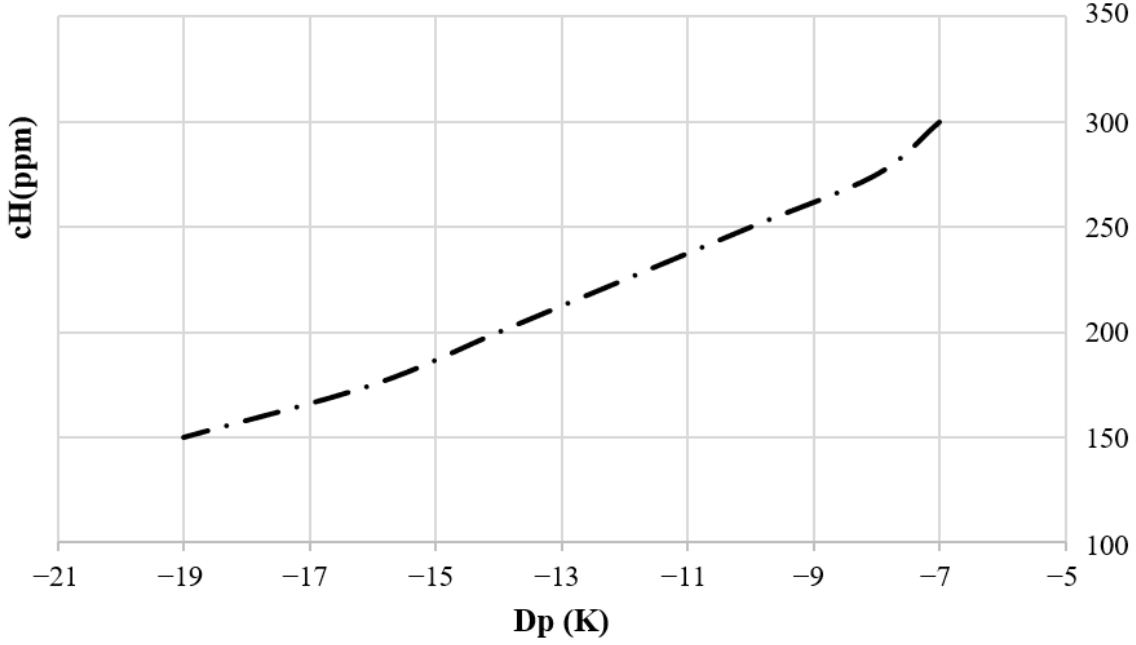
Figure 9. Relationship of the dew point versus hexane concentration.